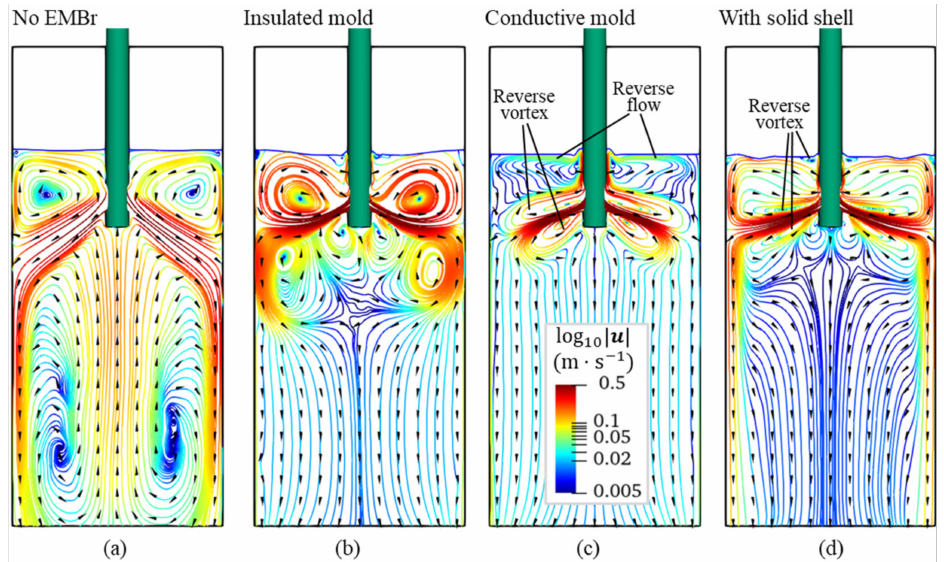
Figure 16. Time averaged velocity stream-lines (midplane), SEN immersion depth of 50 mm: ( a ) Case 0B; ( b ) Case 1B; ( c ) Case 2B; ( d ) Case